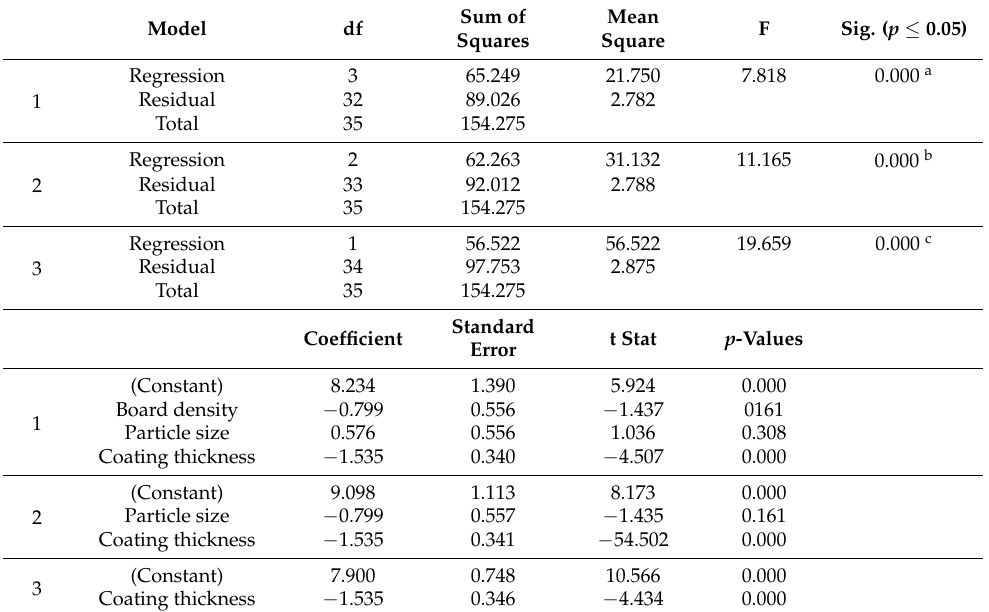
Table 4. Analysis of variance (ANOVA) of multiple regression for the effect of PU coating thickness, different particle size, and board density on the thickness swelling